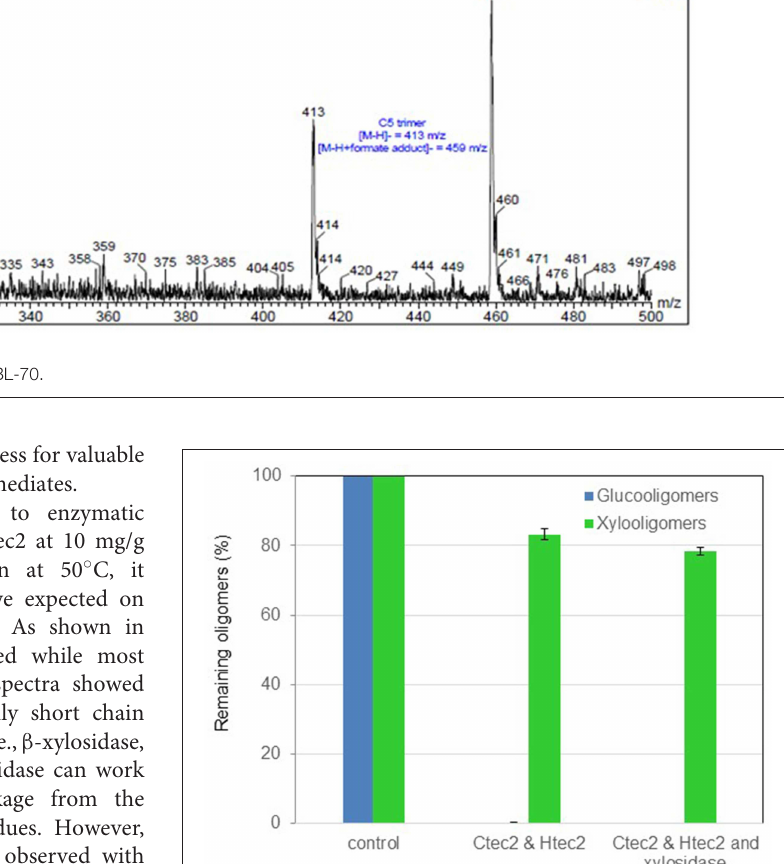
lignin from the black liquor was conducted by acidifying the black liquor to pH 3.0 and precipitating the lignin out by centrifugation. By doing this, 85 ∼ 90% of lignin was removed from the black liquor. The black liquor was then re-adjusted to pH 4.8 and hydrolyzed by Htec2 again. However, it turned out that lignin was not inhibitory to the enzymatic hydrolysis